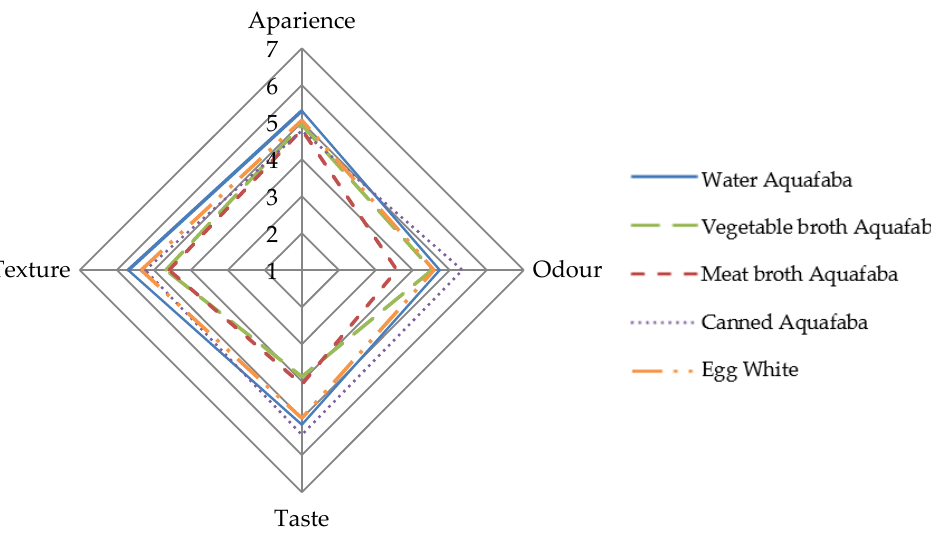
Figure 5. Average scores obtained during the sensory analysis of the different types of meringues made with Pedrosillano chickpea aquafaba and egg white using a 7-points hedonic scale (1 = dislike extremely; 7 = like very much).